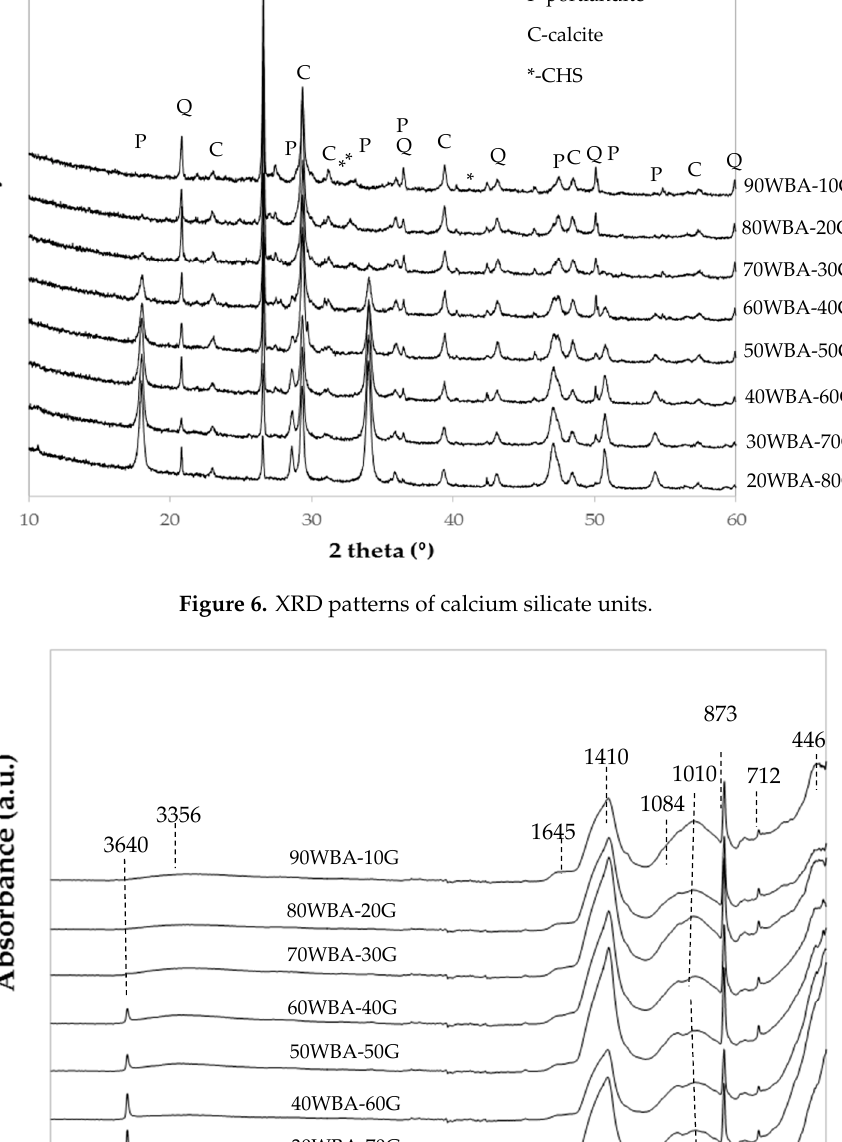
Figure 7. FTIR spectra of calcium silicate units.